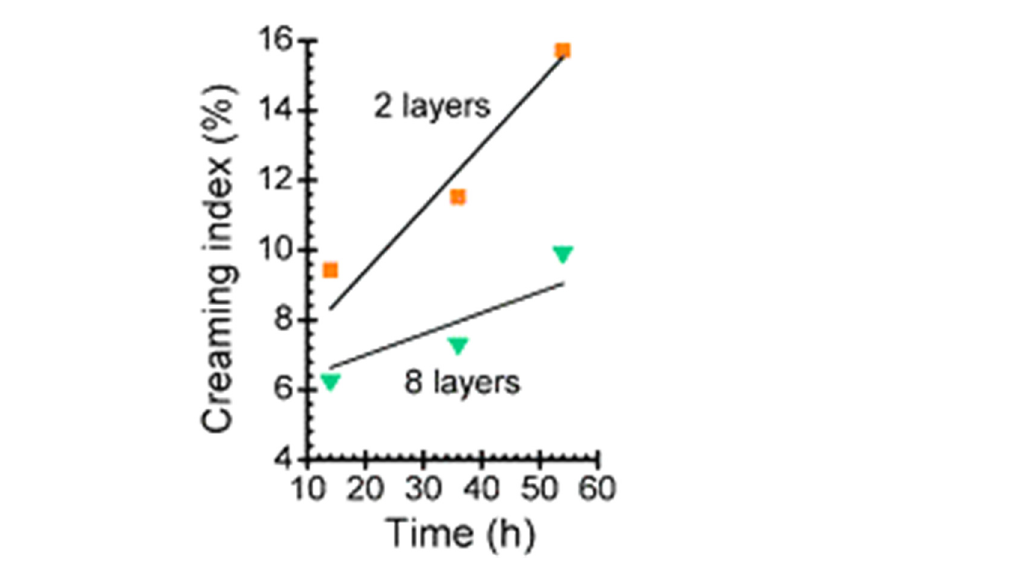
Figure 12. Time evolution of the creaming index for emulsions coated with different numbers of PSS and poly(allylamine hydrochloride) (PAH) layers. Reprinted with permission from reference [290]. Copyright (2011) with permission from PCCP Owner Societies.